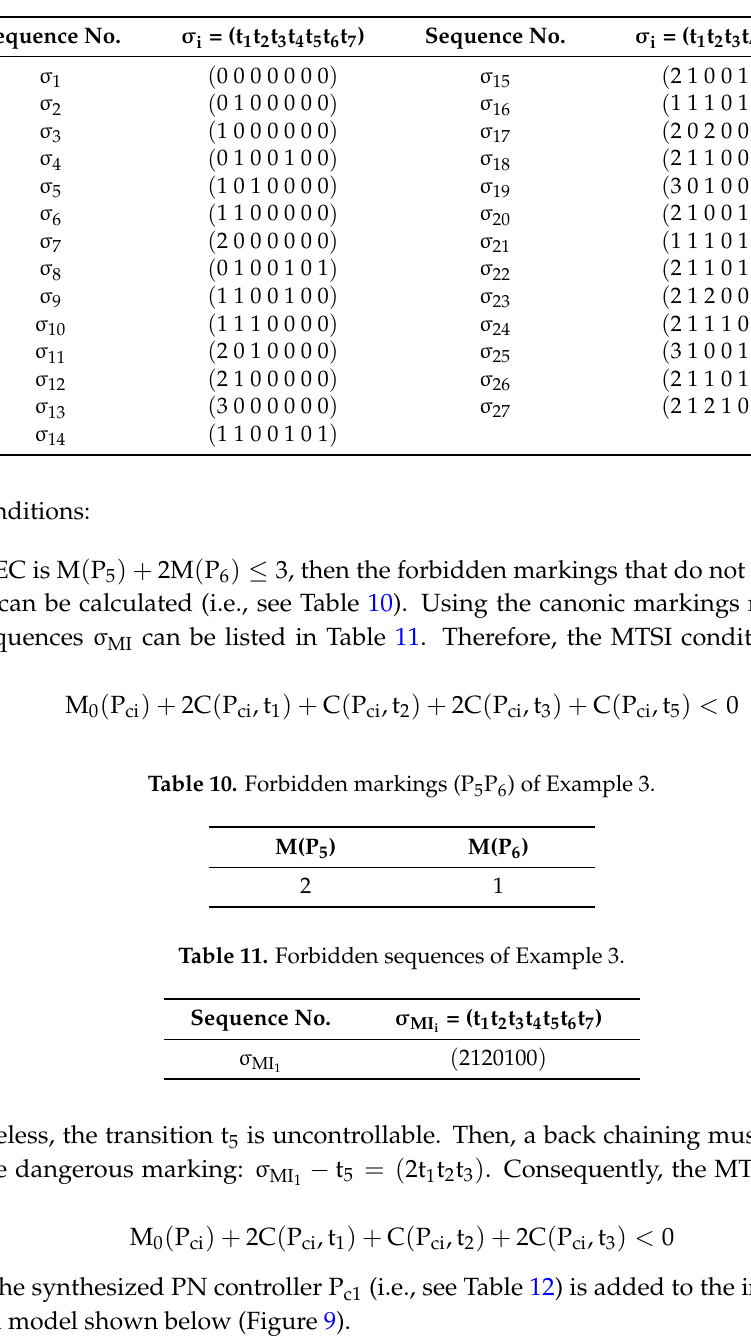
Table 9. Usable sequences of Example 3.